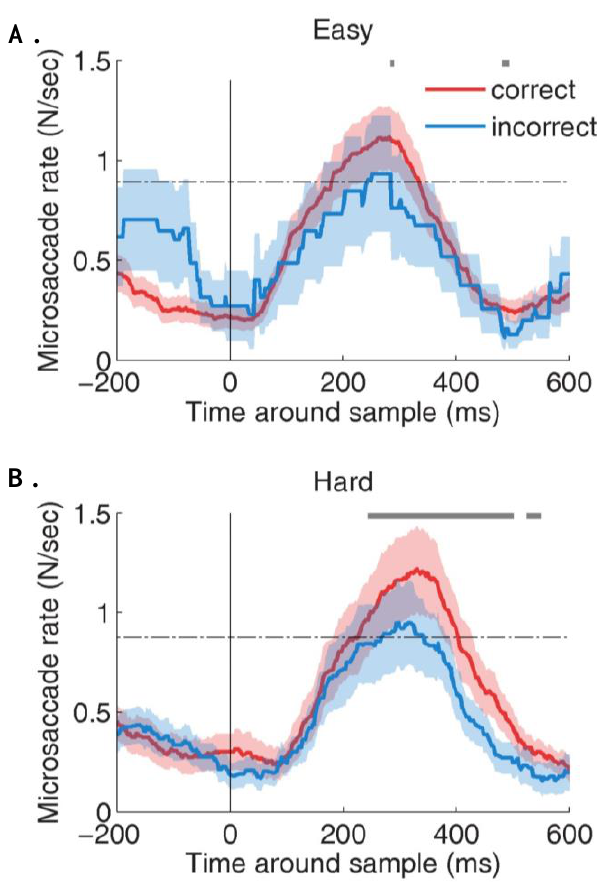
Figure 4. Timecourse of microsaccades in the easy (A) and hard (B) MTS task conditions. Gray line indicates signifi- cance for one-tailed paired t-tests using Bonferroni Correc- tion. α= 0.01. Shaded areas indicate S.E.M across